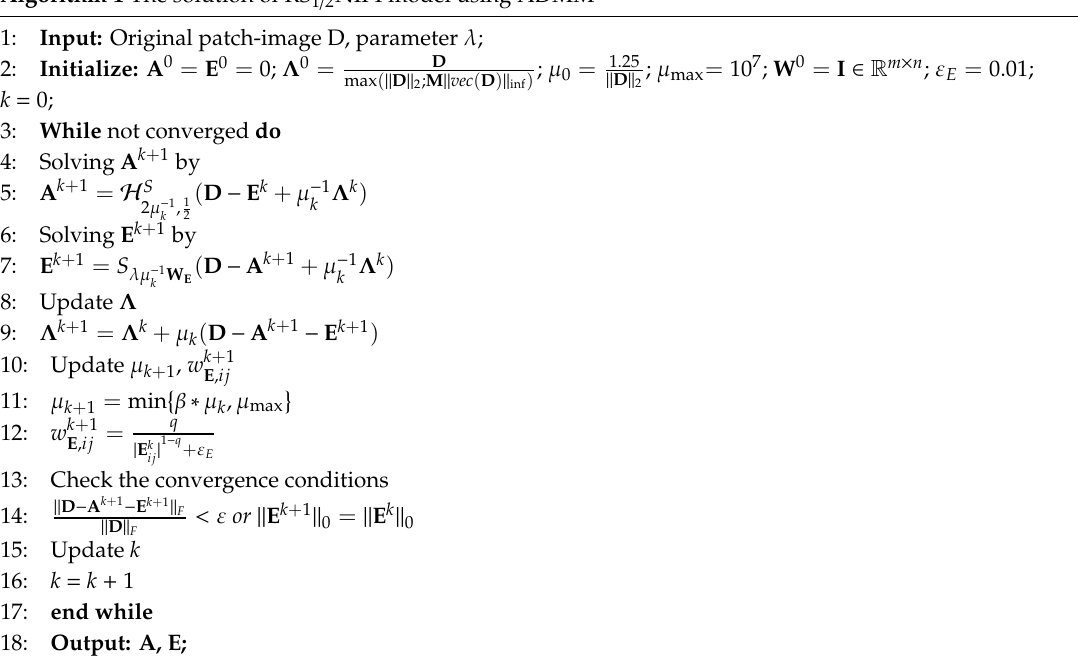
Algorithm 1 The solution of RS 1 / 2 NIPI model using ADMM